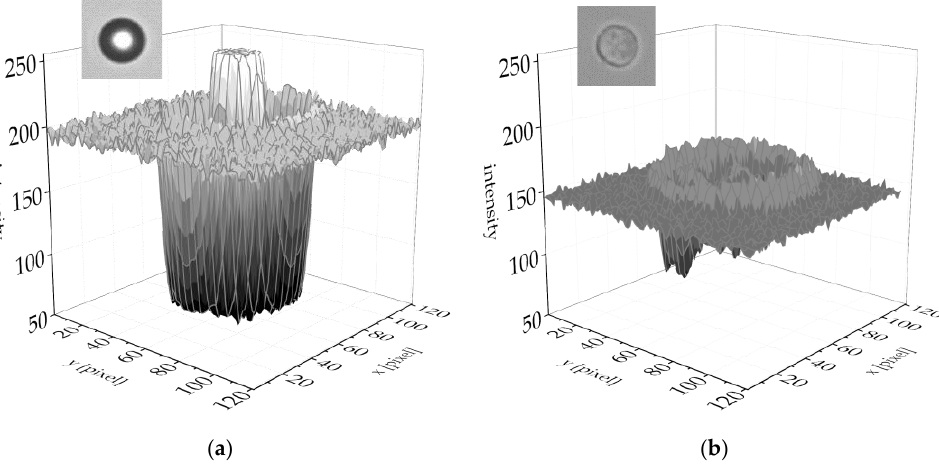
Figure 1. Intensity profiles of 2-dimensional bright field images of ( a ) carboxylated polystyrene microspheres and ( b ) the MCF-7 breast cancer cell line.